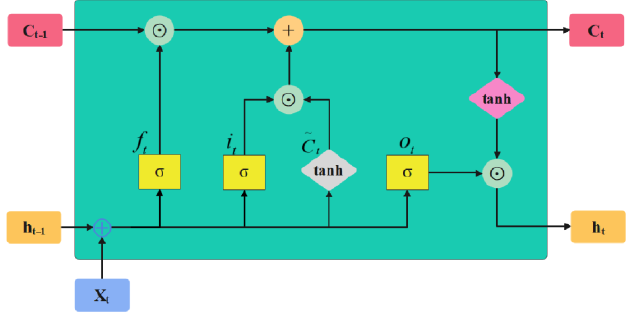
Figure 2. LSTM structure diagram.